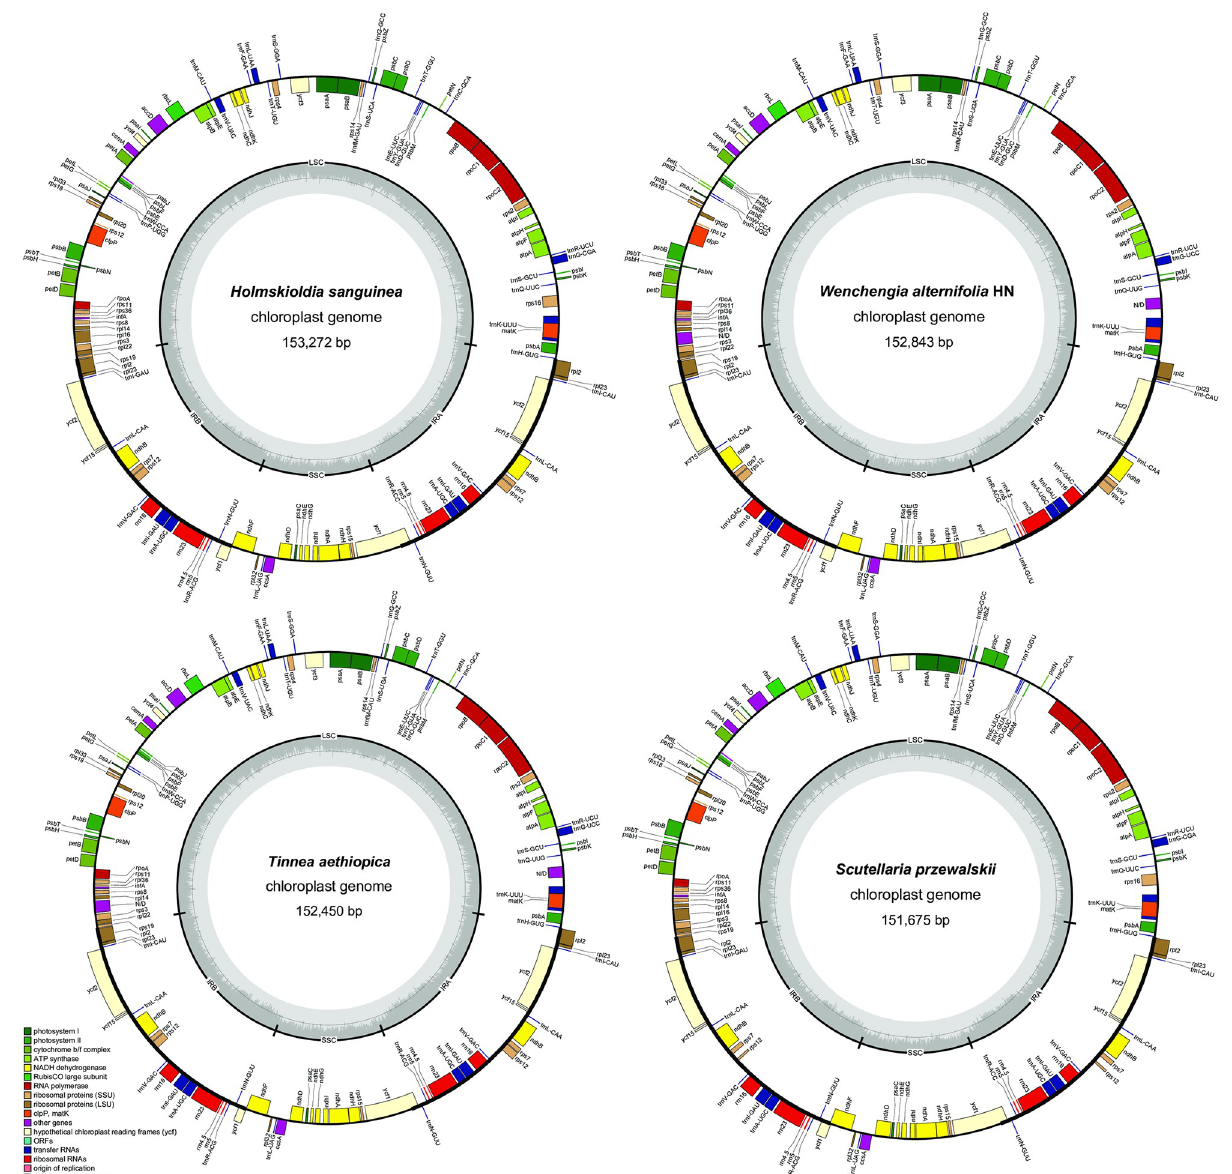
Fig 1. Complete plastome maps of Holmskioldia sanguinea , Wenchengia alternifolia , Tinnea aethiopica , and Scutellaria przewalskii .